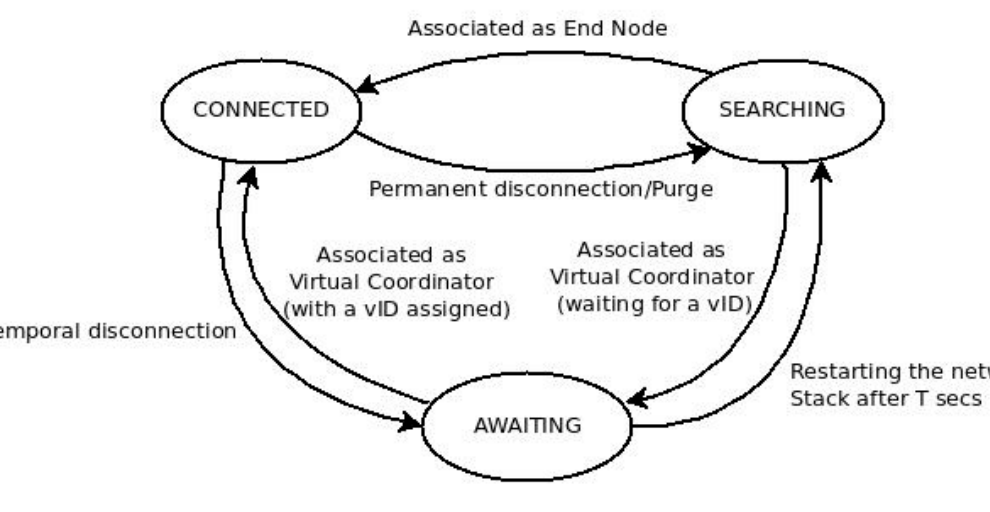
Figure 4. DARP state machine.